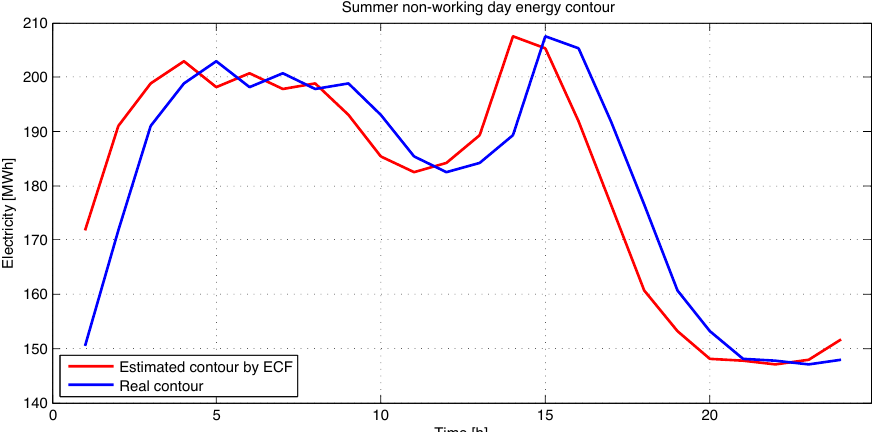
Figure 5. Estimation of energy contour by Frequency Feature Based Method (ECF) for a summer non-working